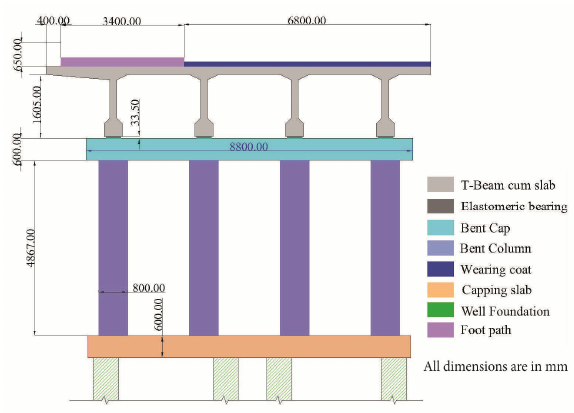
Fig. 2. Cross sectional elevation of the